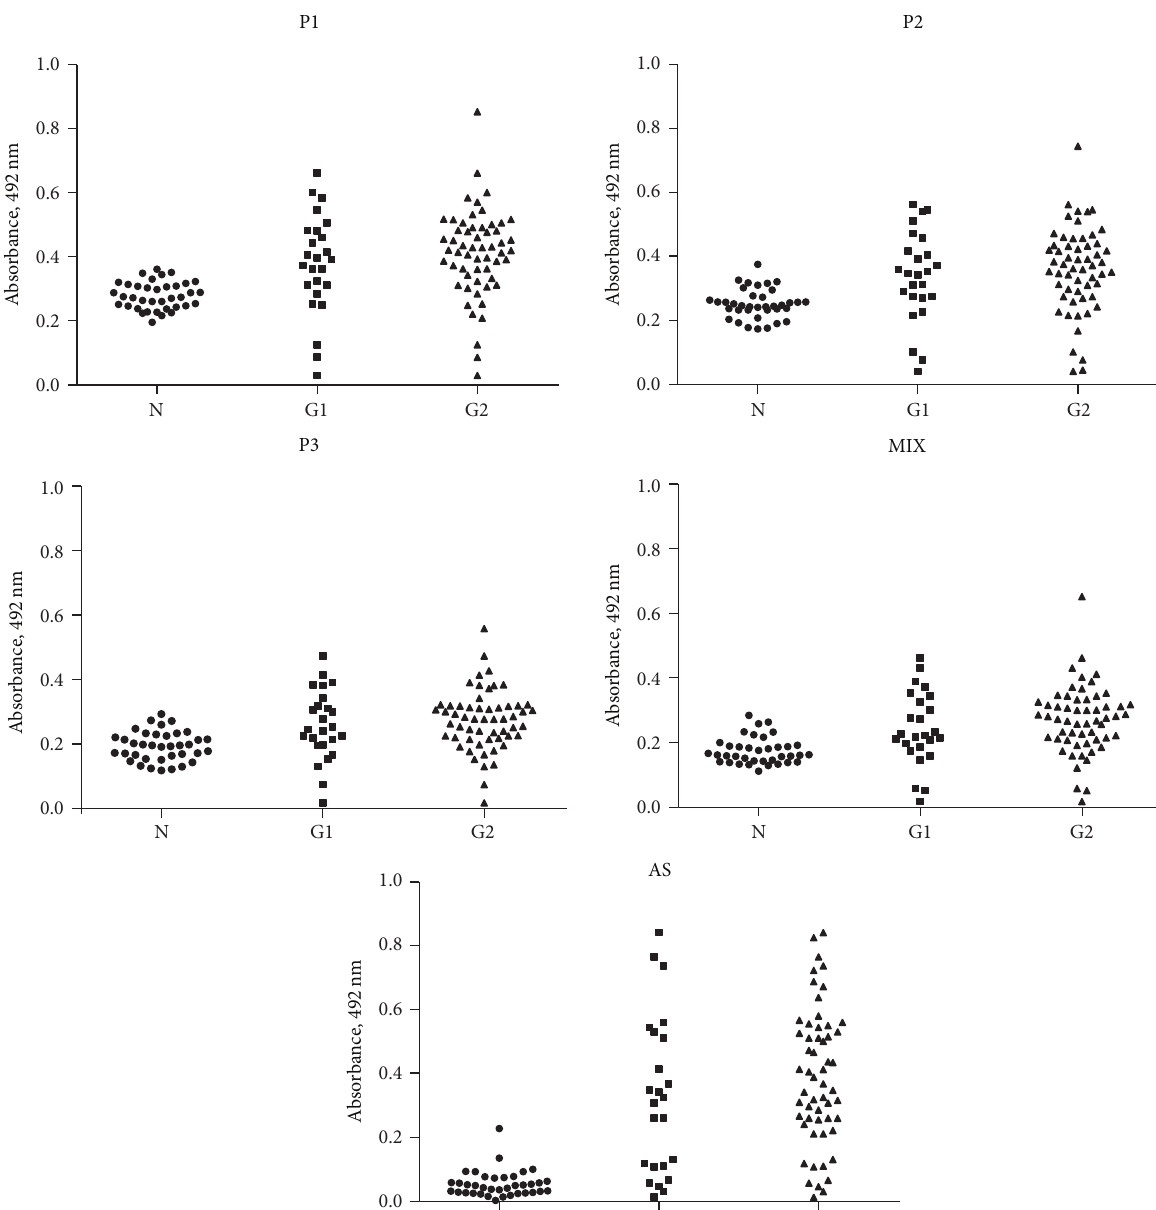
Figure 3: Reactivity of peptides P1, P2, P3, MIX, and SA against sera from CL patients (G1: Group 1, G2: Group 2) and negative control (N).